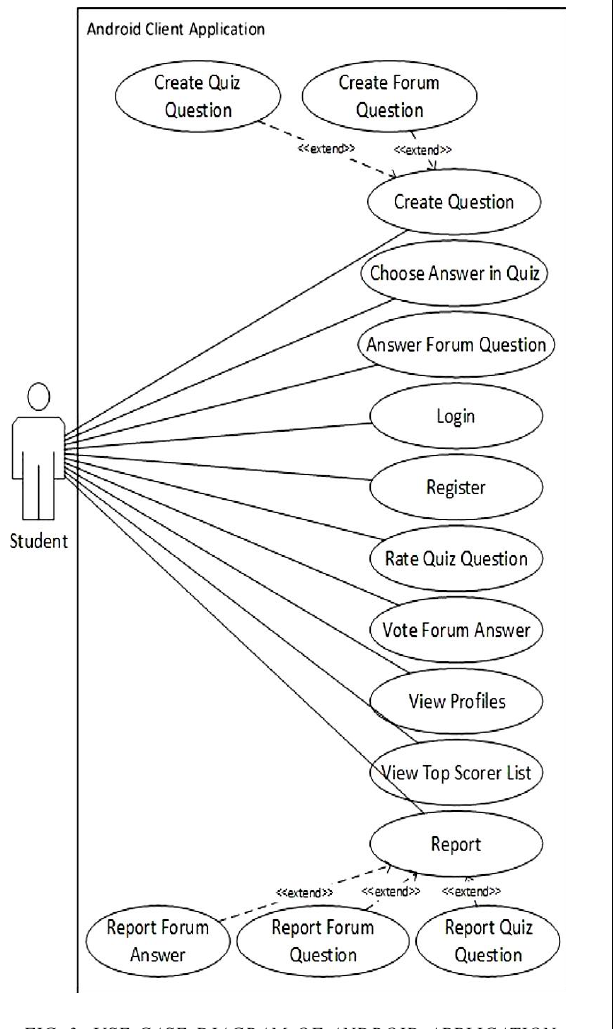
FIG. 3. USE-CASE DIAGRAM OF ANDROID APPLICATION